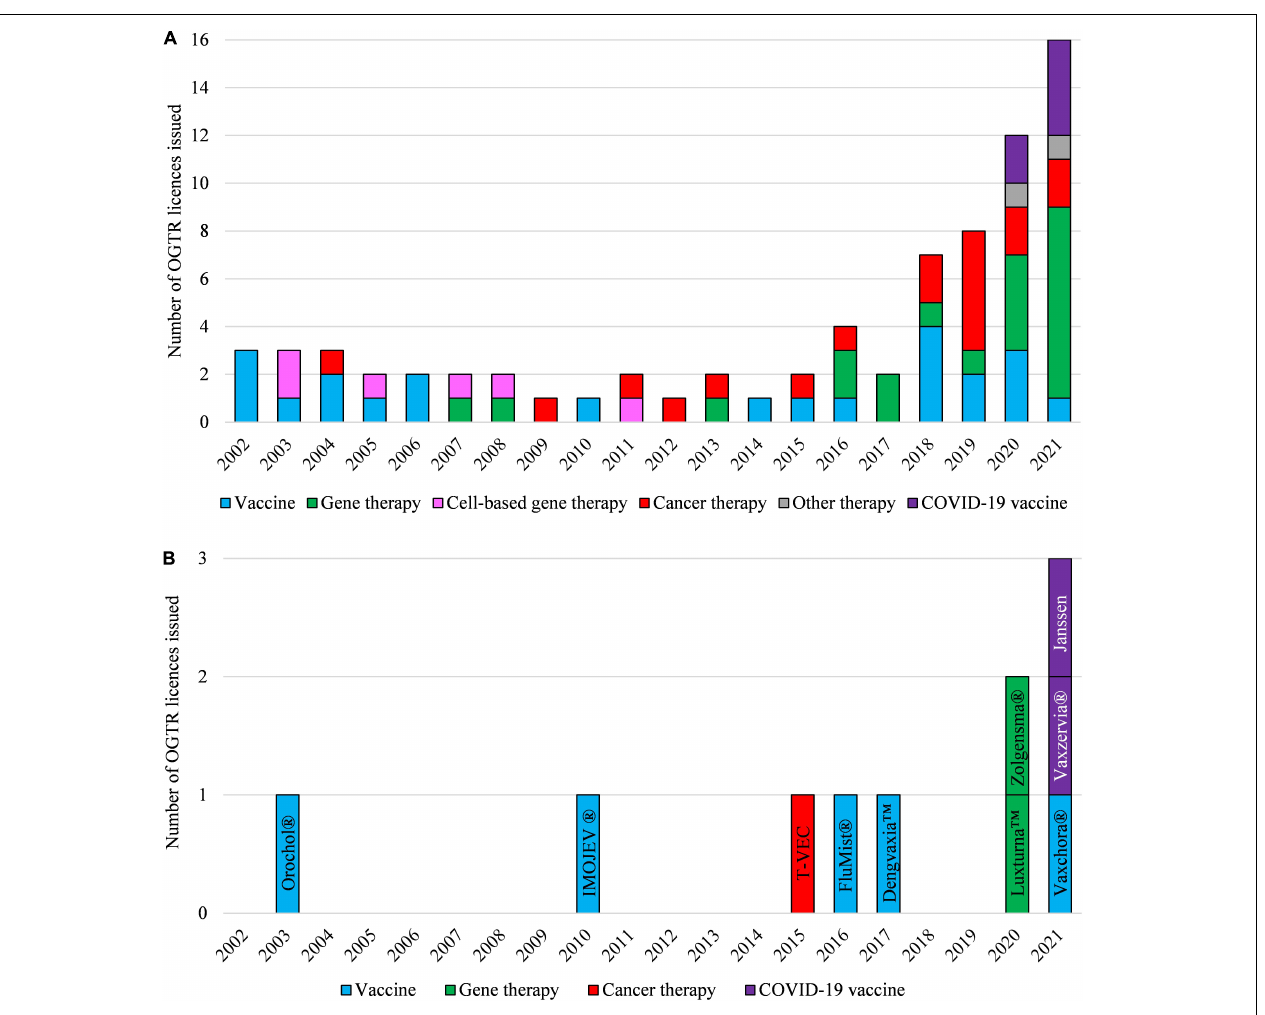
FIGURE 4 | Types of OGTR licenses issued for human clinical trials with GMOs (A) and for commercial therapeutic use of GMOs (B) over the last 20 years. (A,B) The year of an OGTR license issue may not have been in the same year that an application to conduct use of the GMO was received. Cell-based therapy (pink shading, A ) ceased to be regulated by the OGTR in 2011. (B) Key: Orochol (Cholera vaccine, live oral); IMOJEV ( Japanese encephalitis vaccine, live, attenuated); T-VEC (IMLYGIC, Talimogene laherparepvec); FluMist (Influenza vaccine); Dengvaxia (Dengue tetravalent vaccine, live); Luxturna (Voretigene neparvovec); Zolgensma (onasemnogene abeparvovec); Vaxchora (Cholera vaccine, live oral); Vaxzervia (COVID-19 vaccine, AstraZeneca); Janssen (COVID-19 vaccine, Janssen). For further information and details of these data see Supplementary Tables 1 , 2